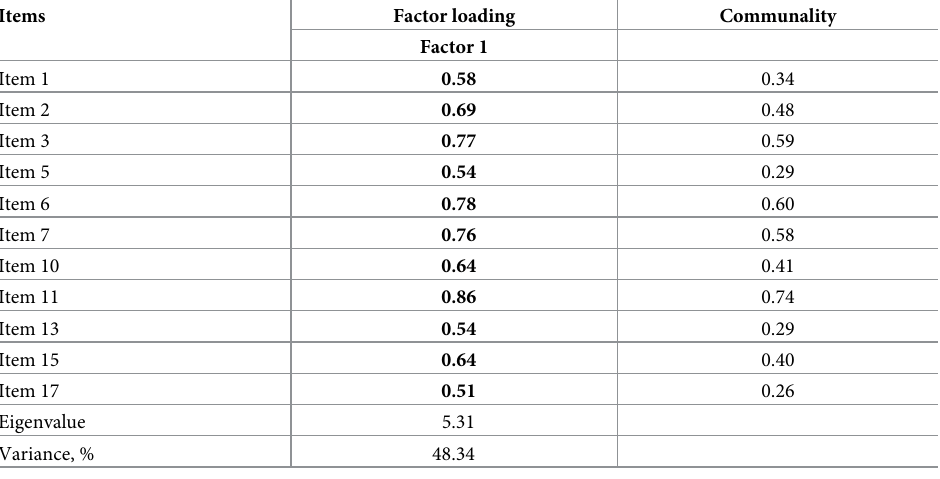
Table 3. Exploratory factor analysis of Tampa Scale of Kinesiophobia (n = 178). Items Factor loading Communality Factor